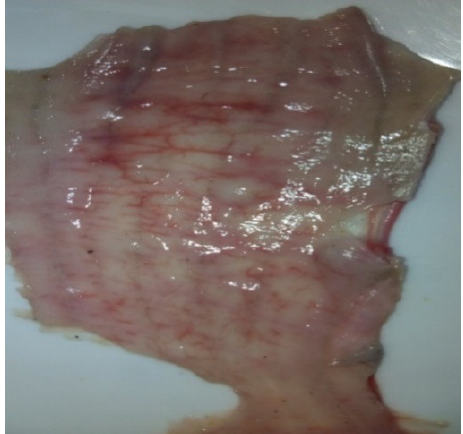
Fig. 4. Intestinal section showing linear discontinuous areas of haemorrhage (Zebra stripes)